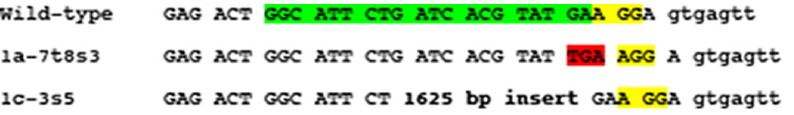
Figure 1. Sequence alignment of part of the first exon of Efe-afpA of the wild-type Rose City isolate of E. festucae , and the two knockout mutants. A single base pair insertion (T) in 1a-7t8s3 introduced a stop codon, highlighted in red. Knockout isolate 1c-3s5 had a 10 bp deletion of Efe-afpA and a 1625 bp insertion, which was a fragment from the transformation vector pG4. The target guide RNA sequence and PAM sequence designed for CRISPR-Cas9 are highlighted in green and yellow, respectively. Upper case letters indicate Efe-afpA coding sequence and lower case letters indicate intron sequence.